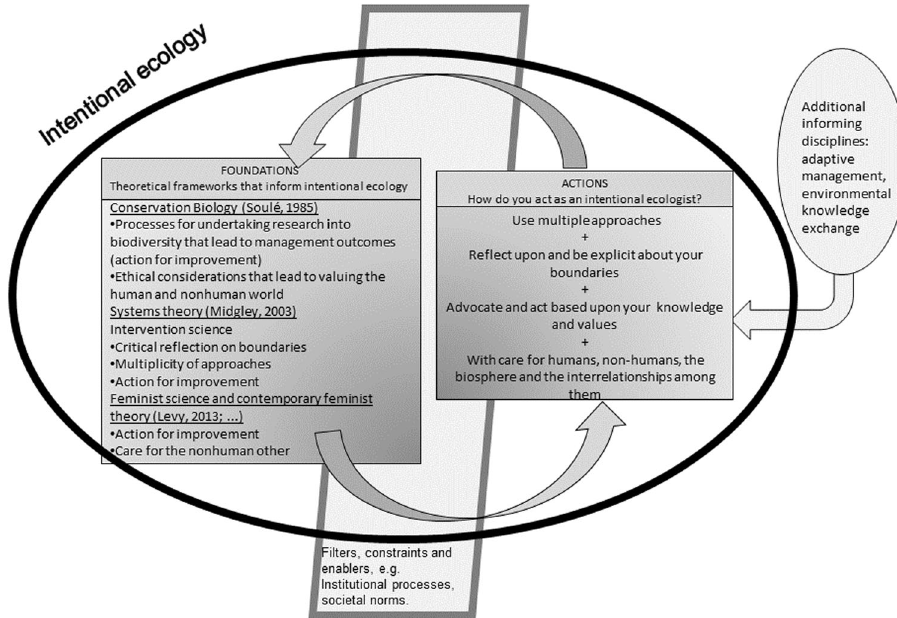
Fig. 1 A schematic of intentional ecology. The foundations of intentional ecology and the actions that are integral to intentional ecology are indicated in boxes. Informing disciplines contributing to intentional ecology are depicted in a circle. External fi lters that in fl uence the relationship between foundations and actions are indicated in a box. The arrows indicate the interrelationships between foundations, actions, fi lters, and informing disciplines.